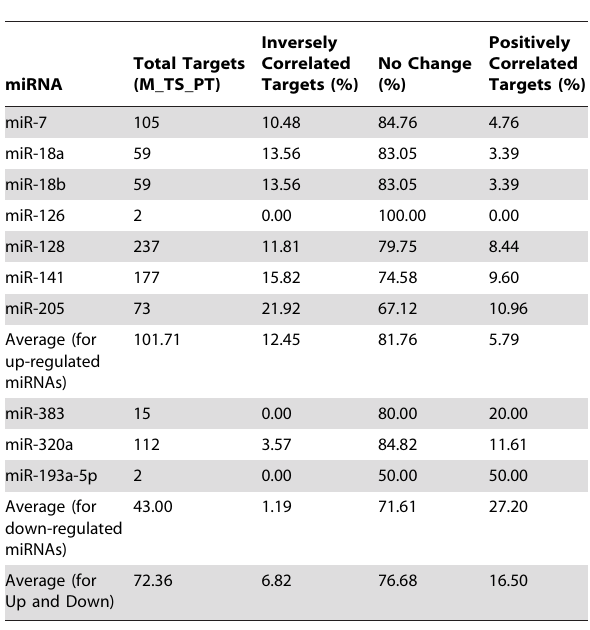
Table 4. Summary values of IC, PC and NC targets in CEPI vs. OSE using overlap of miRanda, TargetScan and PicTar target predictions.